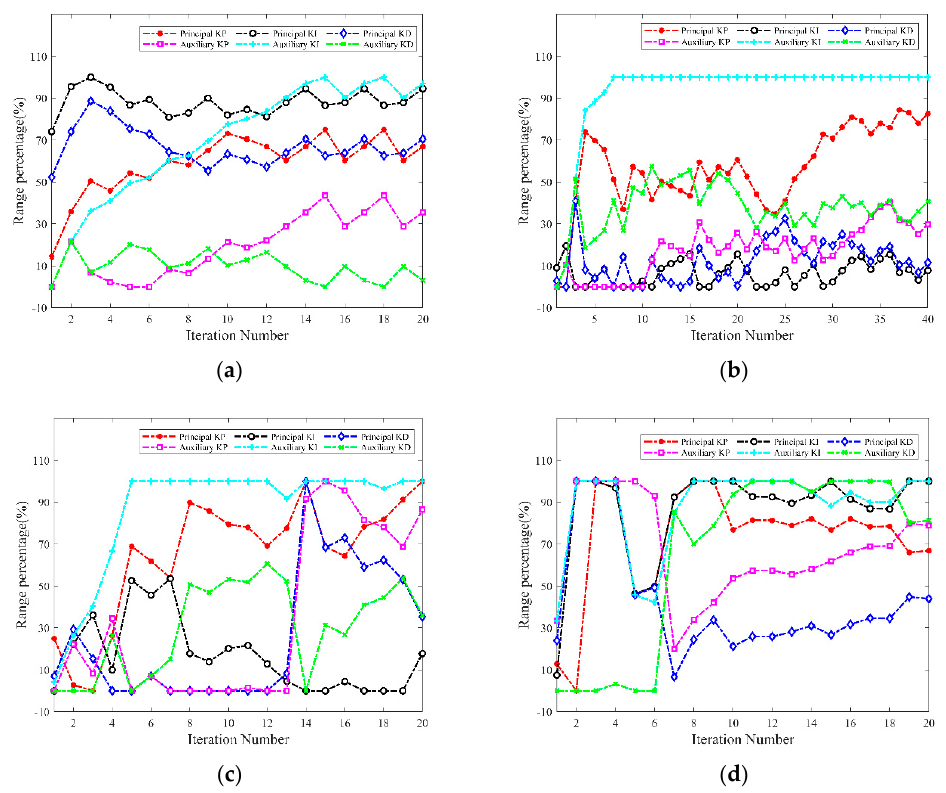
(3) The changing track of algorithm optimization parameters